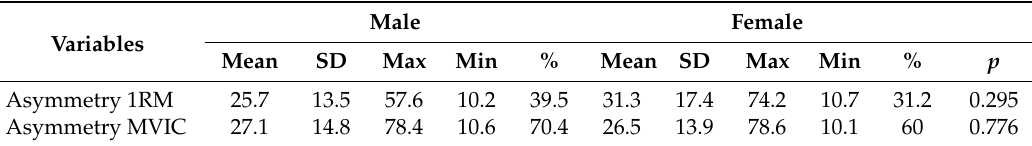
Table 8. Asymmetry of men and